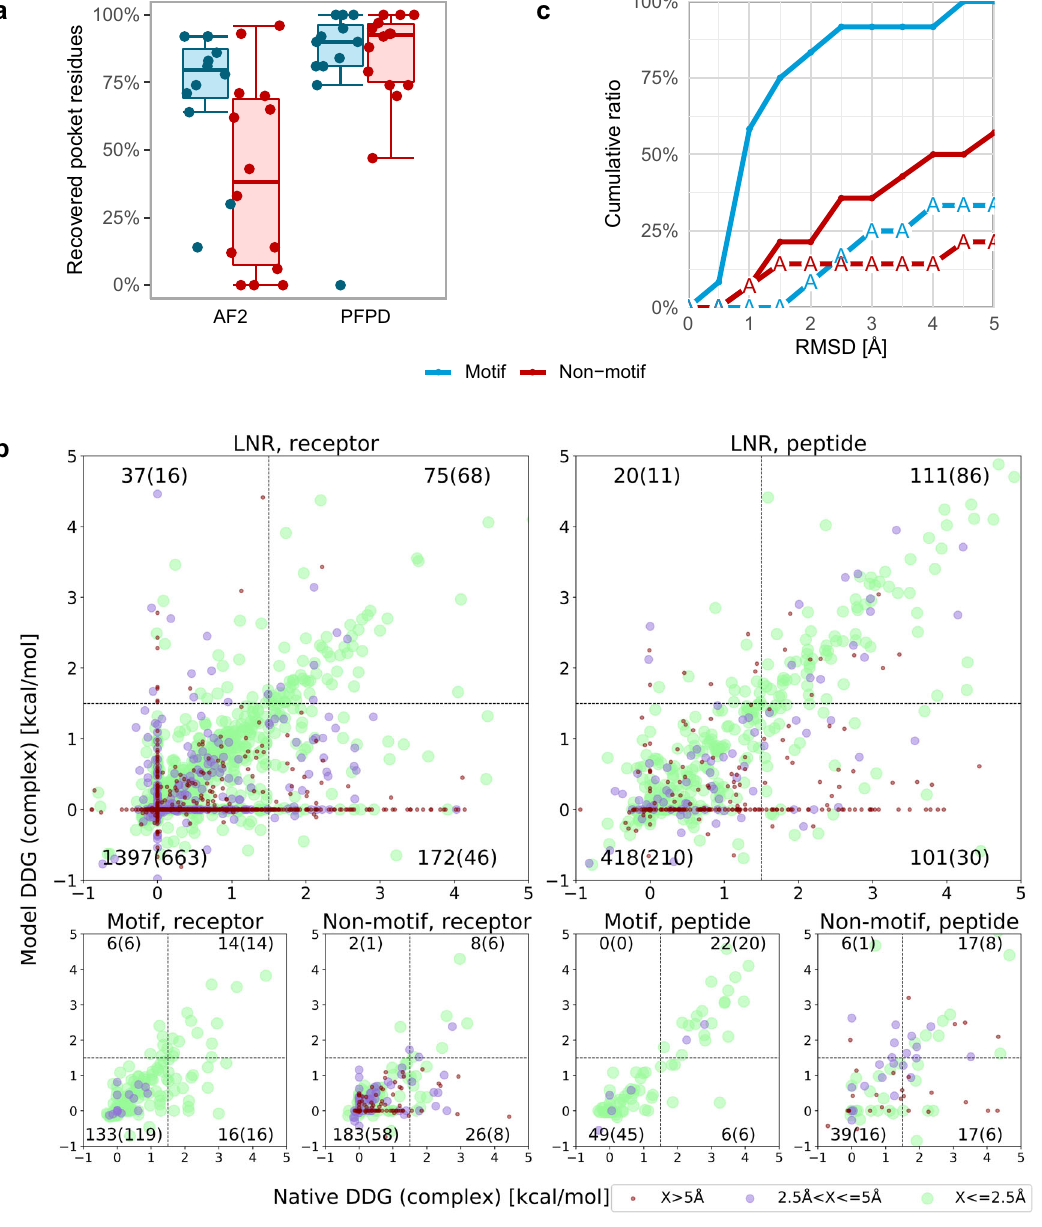
Fig. 3 Recovery of peptide – protein interface characteristics by AF2 models. a AF2 models identify a signi fi cant fraction of the receptor binding pocket residues, even though coverage is reduced compared to PFPD models. Box-and-whisker plots are shown for motif ( n = 12, blue) and non-motif ( n = 14, red) sets, with median as center line, quartiles as box limits, and lower/upper whiskers extending to the maximum/minimum data points within the interquartile range, respectively. b Computational alanine scanning recovers well-predicted interface hotspots, mostly for accurate models (within 2.5 Å RMSD): Comparison of computational Rosetta alanine scanning results applied to the best model vs. the native structure. The vertical and horizontal lines represent the threshold ΔΔ G = 1.5 kcal/mol used to de fi ne interface hotspots. The different colors represent distinct bins of RMSD (of the model used for alanine scanning). The number of residues in each quadrant is indicated (counts from models below 2.5 Å are shown in parentheses). c Performance is signi fi cantly reduced if the peptide sequence is changed to poly-alanine, both for motif and non-motif sets. Source data are provided as a Source Data fi